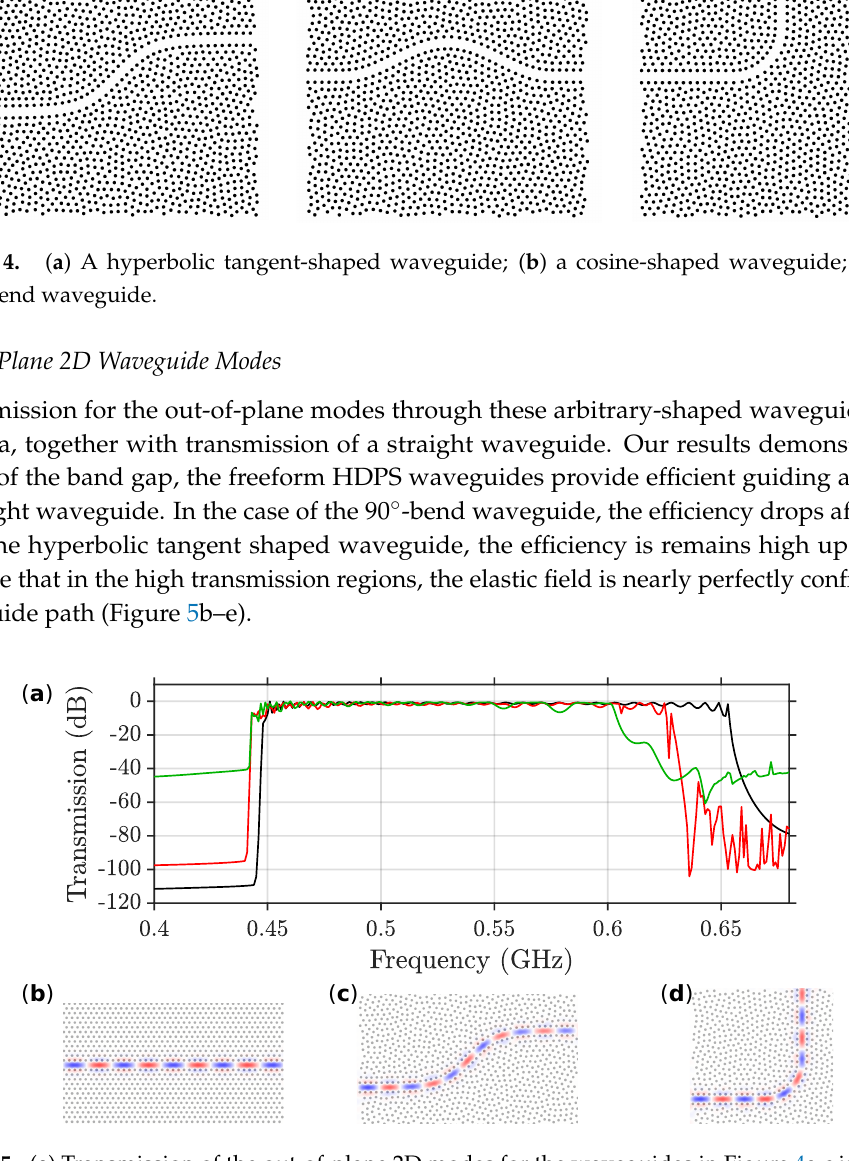
Figure 5. ( a ) Transmission of the out-of-plane 2D modes for the waveguides in Figure 4a,c is shown by the blue, red, and green lines, respectively. With the black lines the corresponding transmitted power of a straight waveguide is shown with the black line for comparision. A snapshot of the elastic field vertical component at a propagating frequency of 0.46 GHz is shown in ( b – d ) for the straight waveguide, and the waveguides in Figure 4a,c,